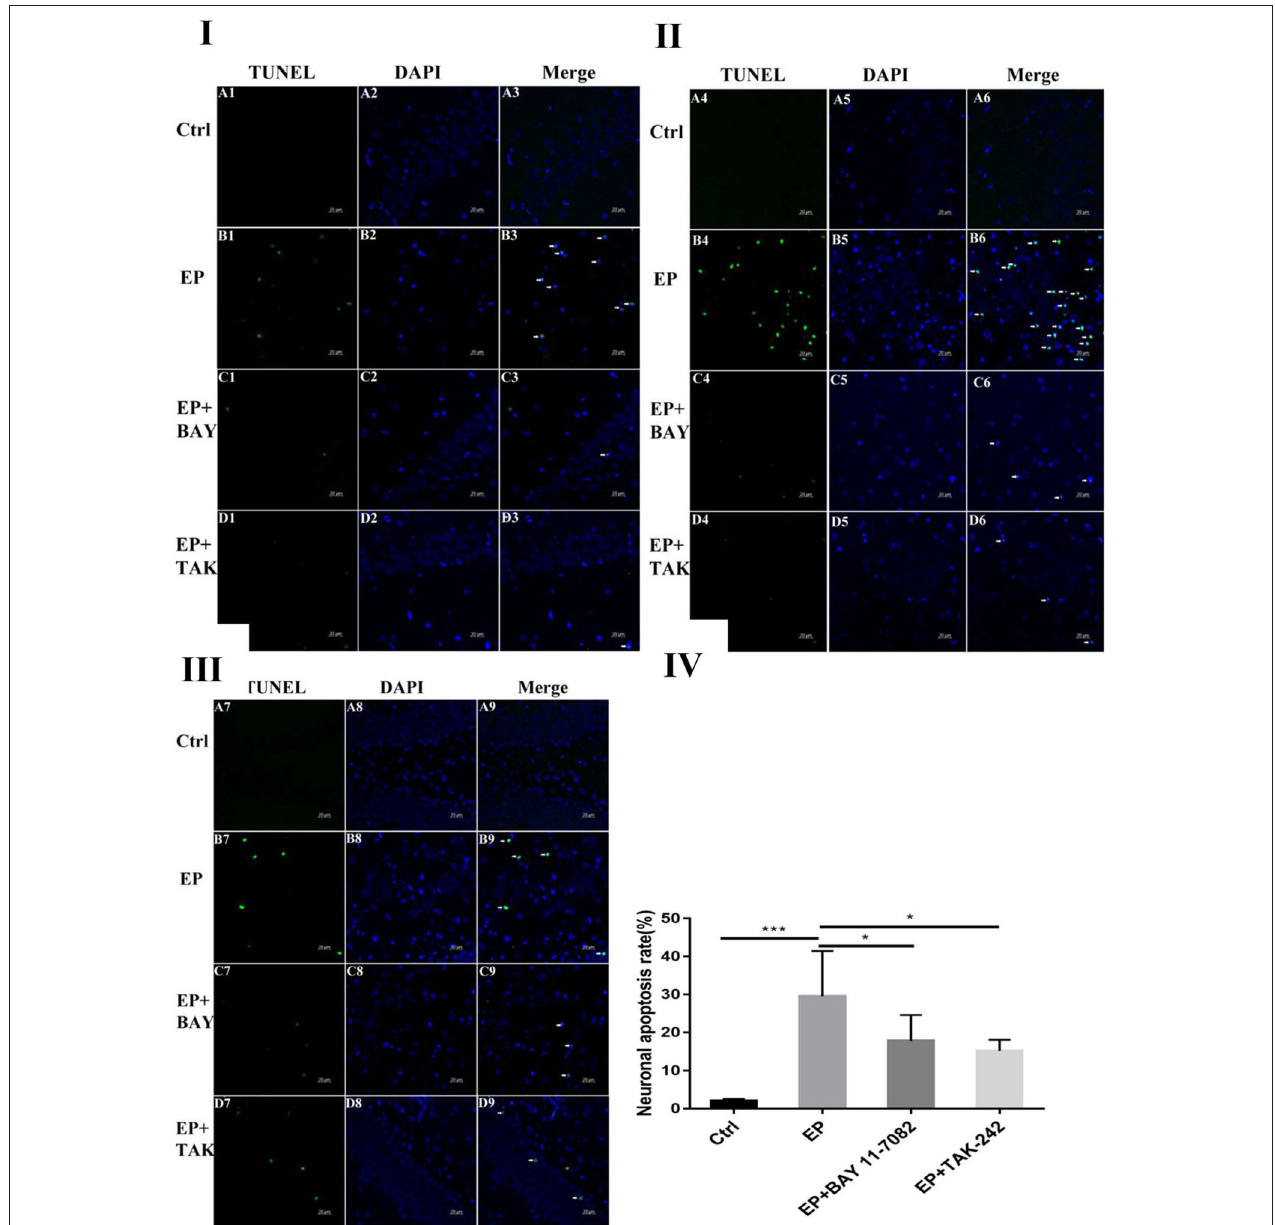
FIGURE 1 | Neuronal damage observed in the hippocampal region ( × 400). * P < 0.05; ** P < 0.01; *** P <